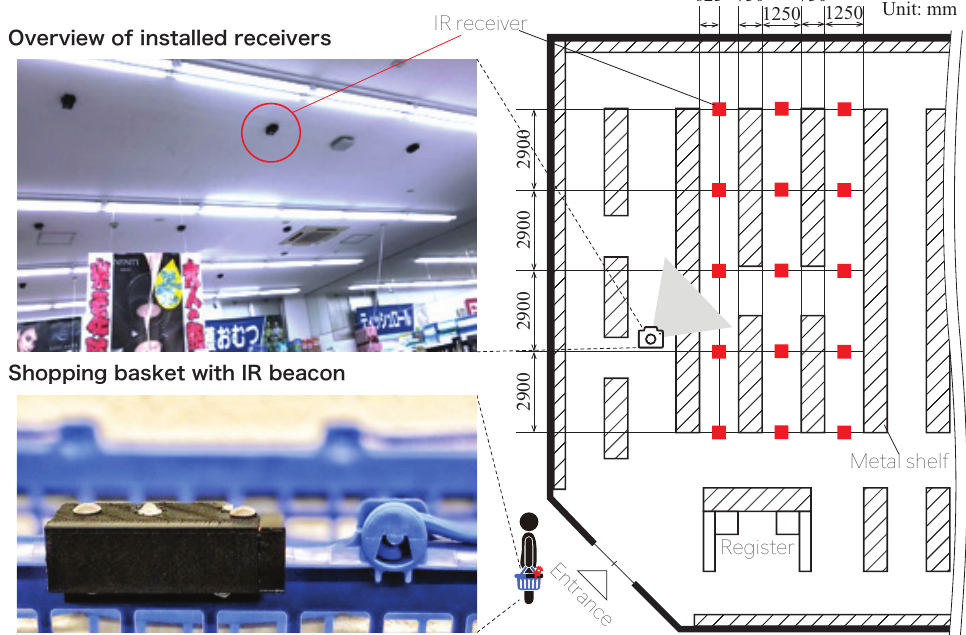
Figure 8. Layout of IR receivers installed in the retail store. The receivers were connected using ZigBee, and power was taken from the outlet. IR receivers were installed on the ceiling of the retail store in the cosmetics sales area ( ∼ 40 m 2